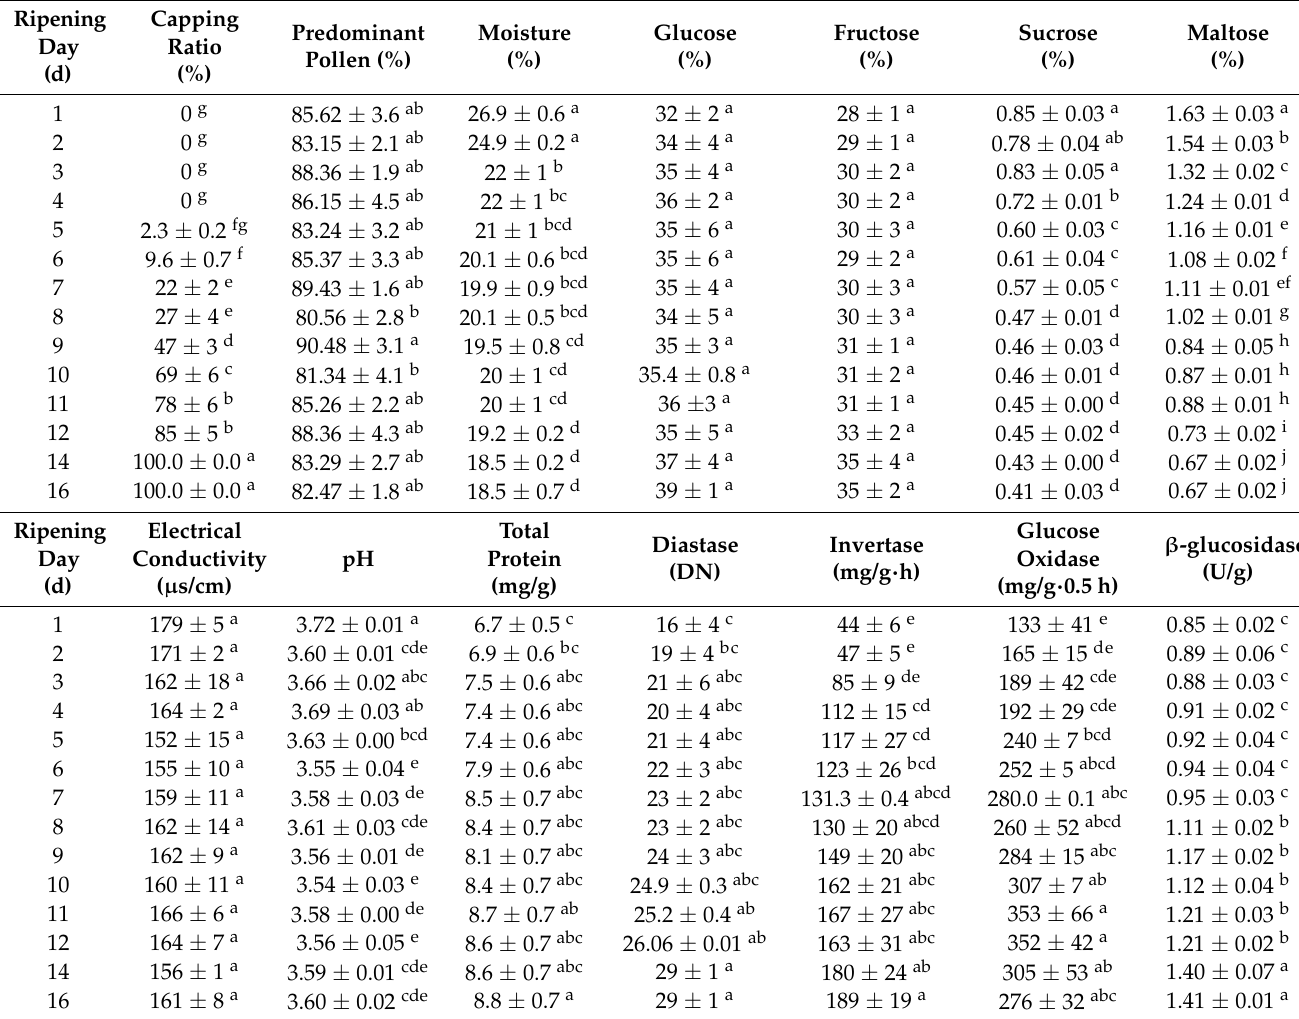
Data represent the mean of triplicate readings ± standard deviations (SD). Different lower case letters correspond to significant differences at p <